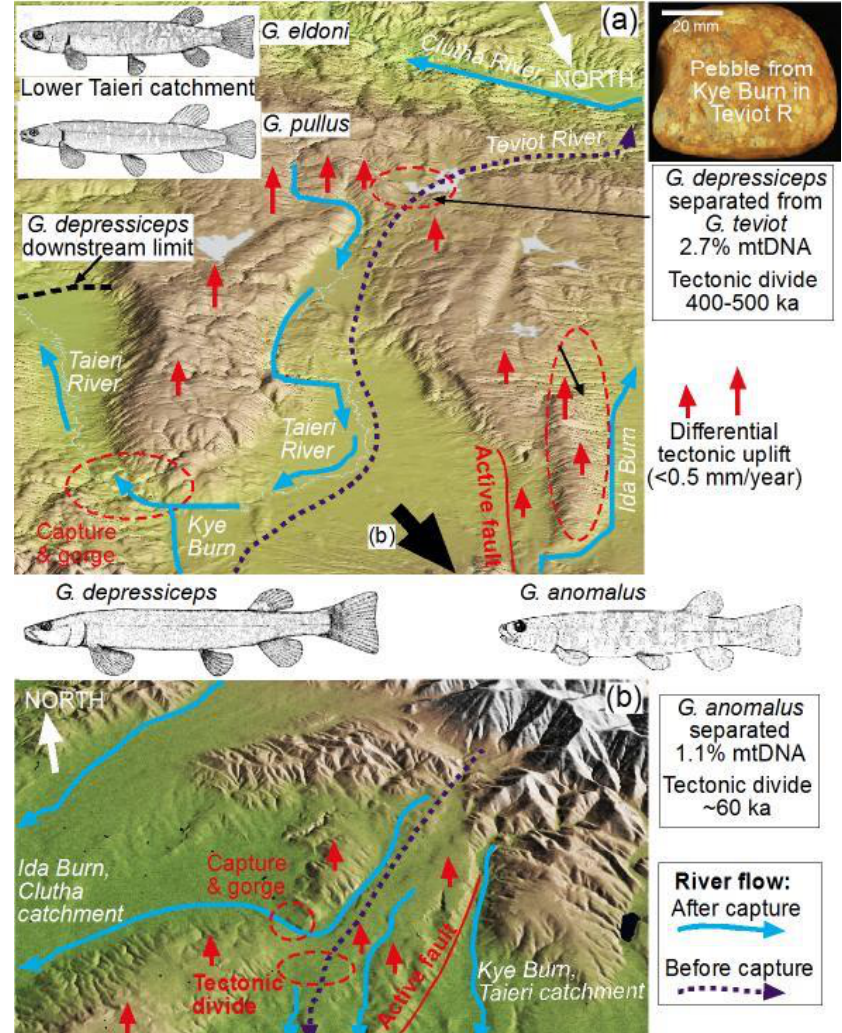
Figure 4. ( a ) Late Pleistocene—recent tectonic compression uplifted folded mountain ranges that now define the boundaries between Taieri and Clutha River catchments in Otago (Figure 1) [6,15]. This